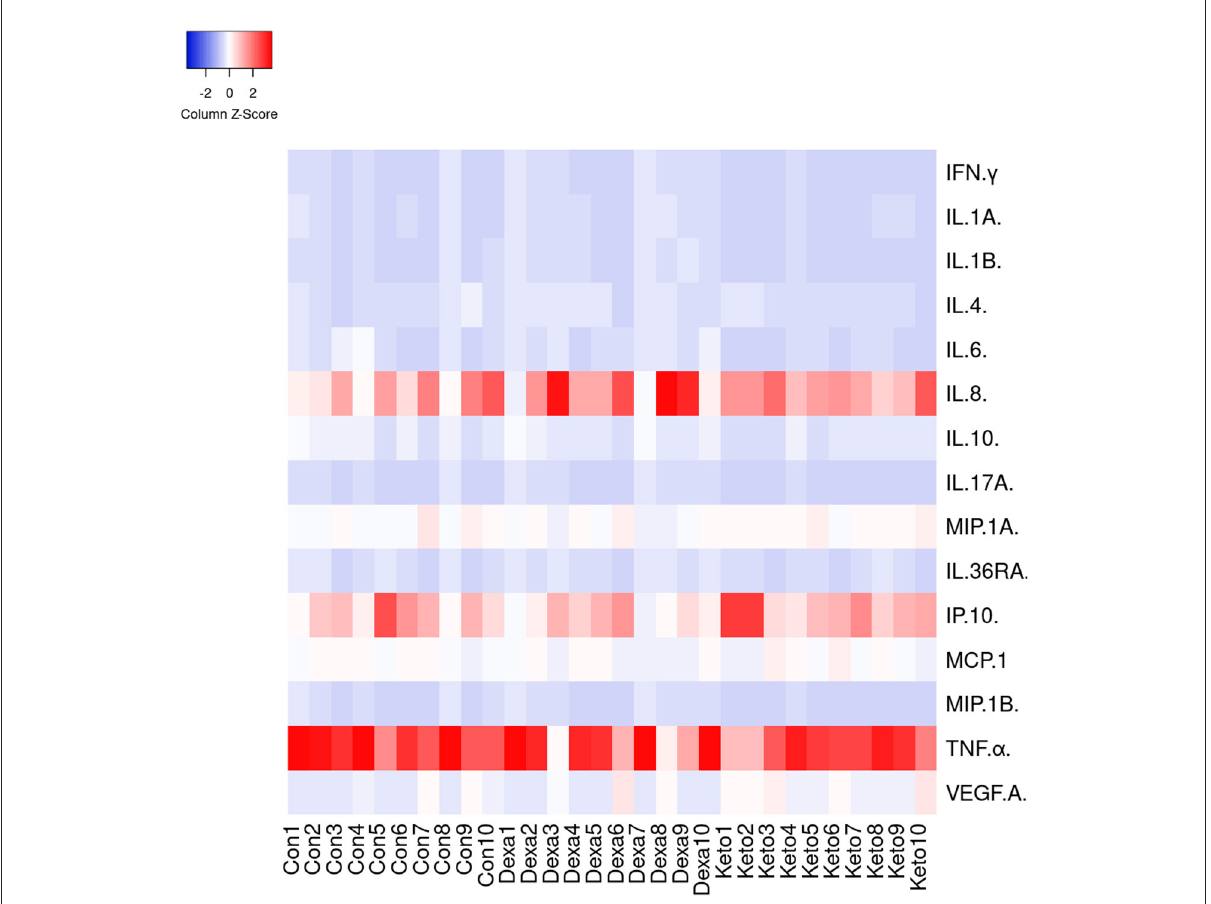
FIGURE5 Heatmap of clustering analysis for different cytokines and chemokines analyzed in serum samples collected at day 3 from 10 goats randomly selected from each group